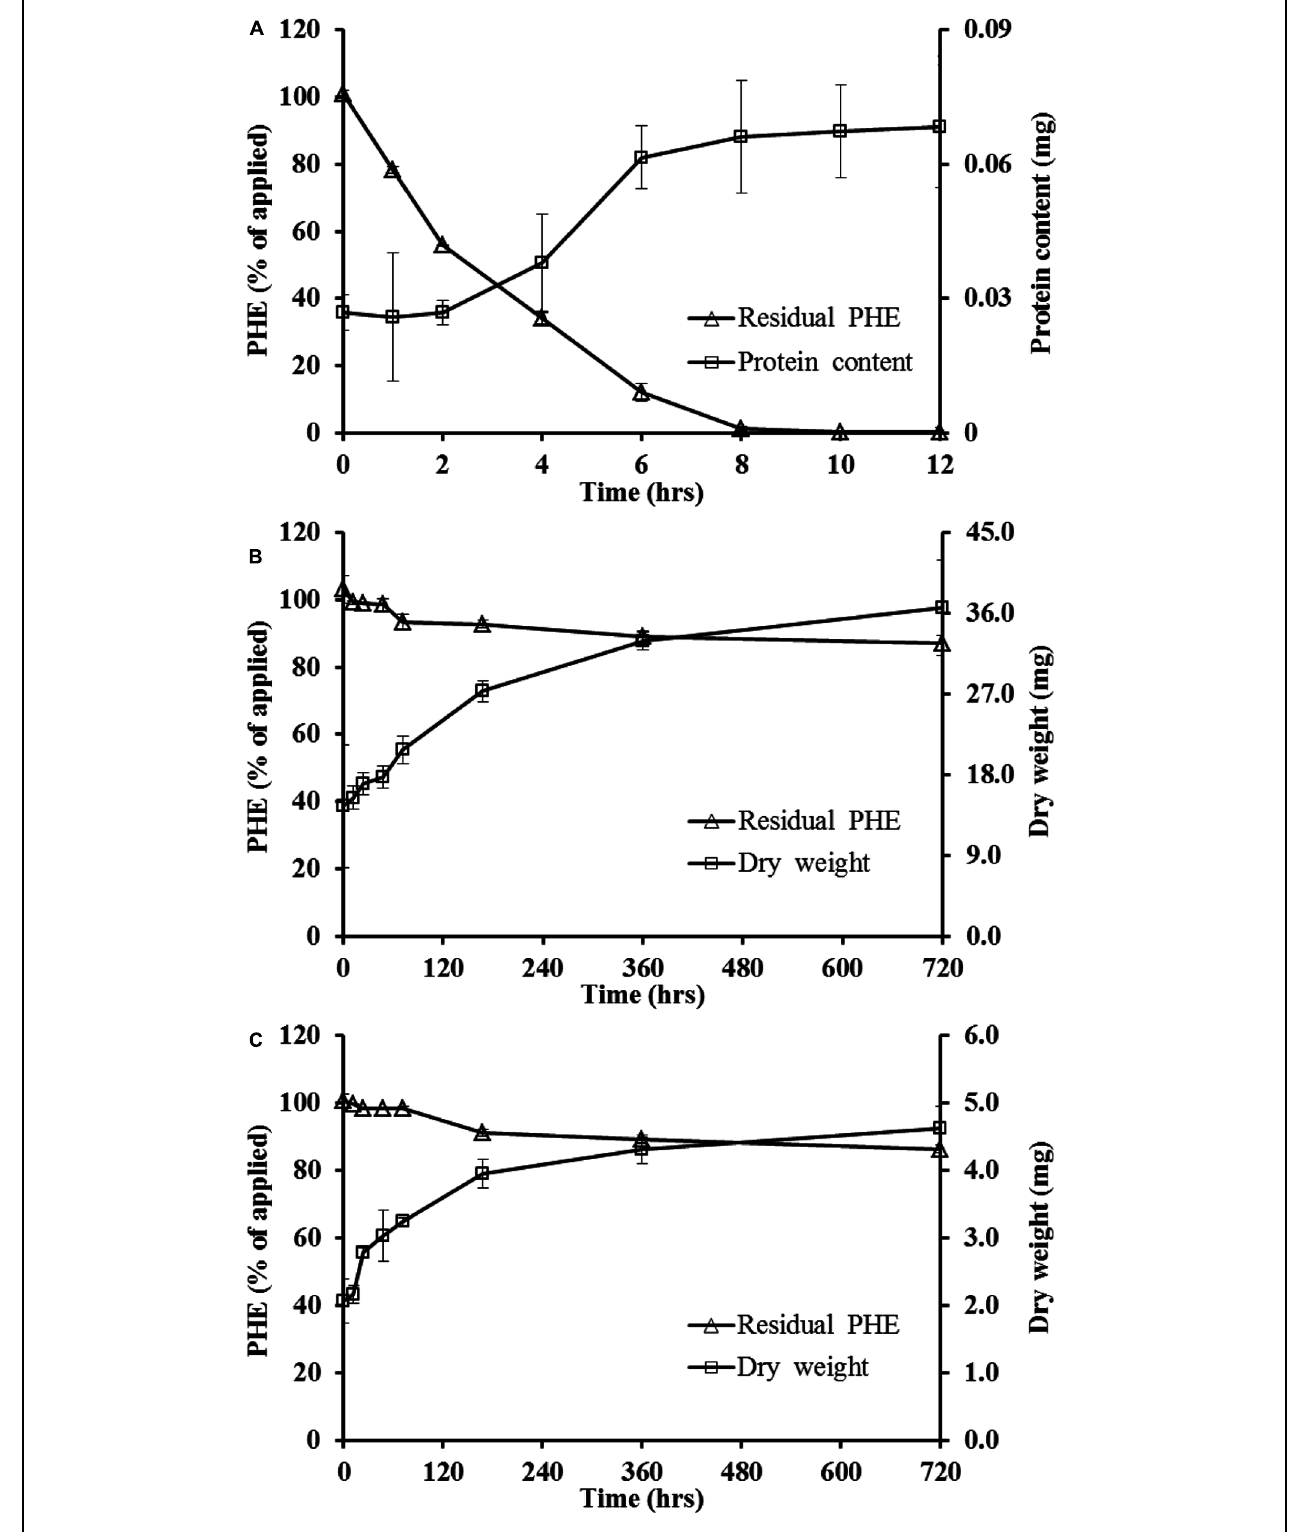
FIGURE 1 | Biodegradation dynamics of phenanthrene (PHE) by Massilia sp. WF1 (A), spore (B), and mycelial pellet (C) of P. Chrysosporium and the growth curve of microorganism in liquid solution cultures at 28 ◦ C. Bars are ± standard deviation of three analyses.